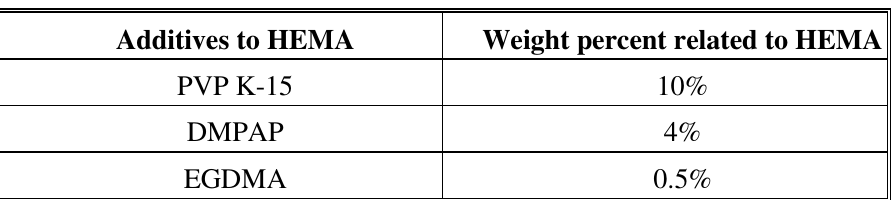
Table 1. Composition (A) of mixture for polyHEMA coatings with PVP K-15 as a filler, expressed in weight percent related to